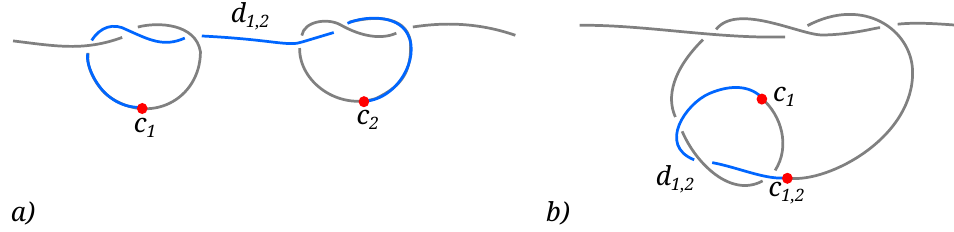
Figure 3. Schematics of the collective order parameter | D | measuring the linear distance between two prime knots. ( a ) When both prime components are isolated , the order parameter is given by | D | = | d | = | c − c | , where c = ( e + s ) /2 is the center of knot i on the chain. Here e 2 i i i 1,2 1 for the last and the first bead of the i -th isolated prime knot; ( b ) When the two knots are intertwined, the center of the hosting knot is taken to coincide with the center of the composite knot c 1,2